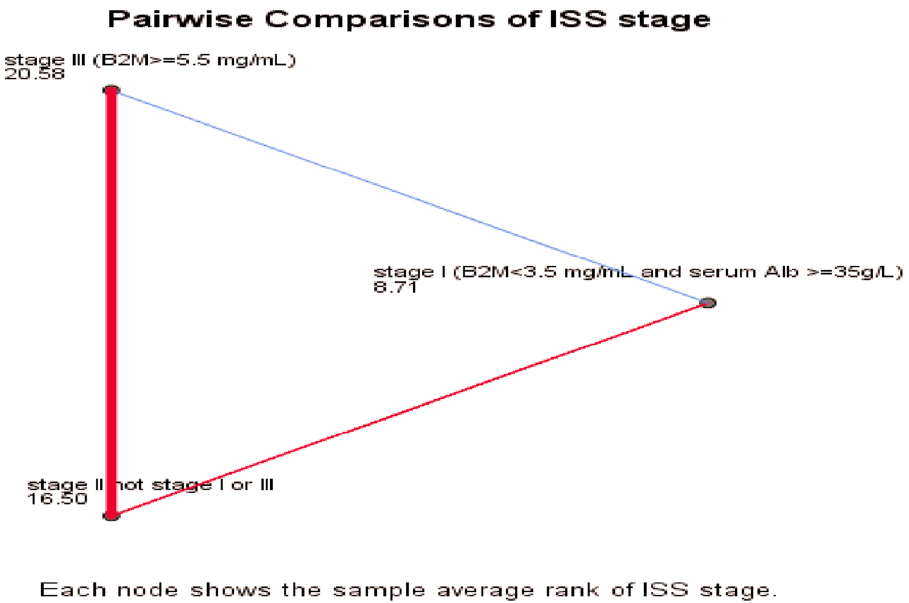
Figure 9. Significant accumulation of PD1+CD4+T cells in stages II and III compared to stage I ( p = 0.049, p = 0.015 respectively), while no significant differences between stages II and III ( p = 0.3).